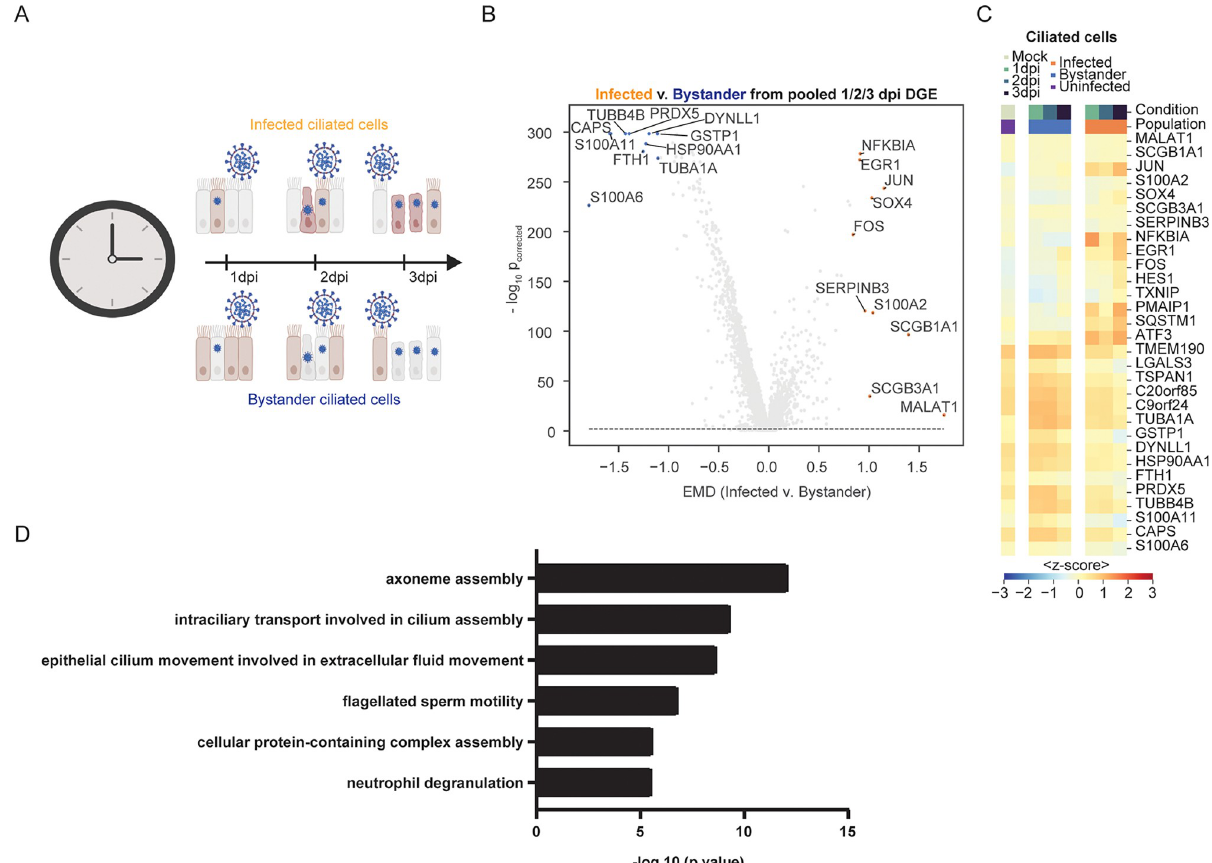
Fig 6. Expression of DEGs in ciliated cells in response to SARS-CoV-2 infection. (A) Schematic of the differential expression analysis comparing ciliated cells from the infected and bystander populations. (B) Volcano plots highlighting the most DEGs between infected and bystander populations in ciliated cells pooled from 1, 2, and 3 dpi samples, as ranked by the EMD. The y-axis shows the negative log base-10, Benjamini–Hochberg corrected p -value from a Mann–Whitney U test with a continuity correction, comparing the expression between infected and bystander. The dashed line shows the significance, set at p corrected � 0.01 (see Materials and methods). (C) Heatmap showing the average expression (represented as z-score) in each condition (color bar legend atop heatmap) of the top 15 differentially up-regulated and top 15 down-regulated genes from the analysis in Fig 6A and 6B. (D) Pathway analysis of top and bottom 200 DEGs which are significantly down-regulated in SARS-CoV-2–infected versus bystander ciliated cells. The analysis was done using the PANTHER GO tool with significance assessed using Fisher exact test. The individual numerical value per condition for A–D is listed in S1 Data. The raw data for generating B–D are listed in S3 Data. Illustration for Fig 6A was created using BioRender.com. DEG, differentially expressed gene; dpi, days post-infection; EMD, Earth Mover’s Distance; SARS-CoV-2, Severe Acute Respiratory Syndrome Coronavirus 2.